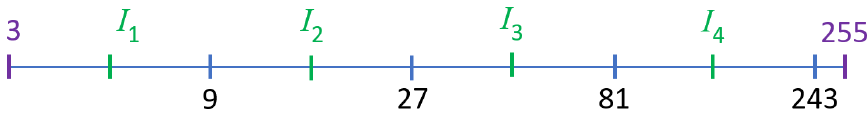
Figure 5. A scheme of the segment [ 3,255 ] separation.